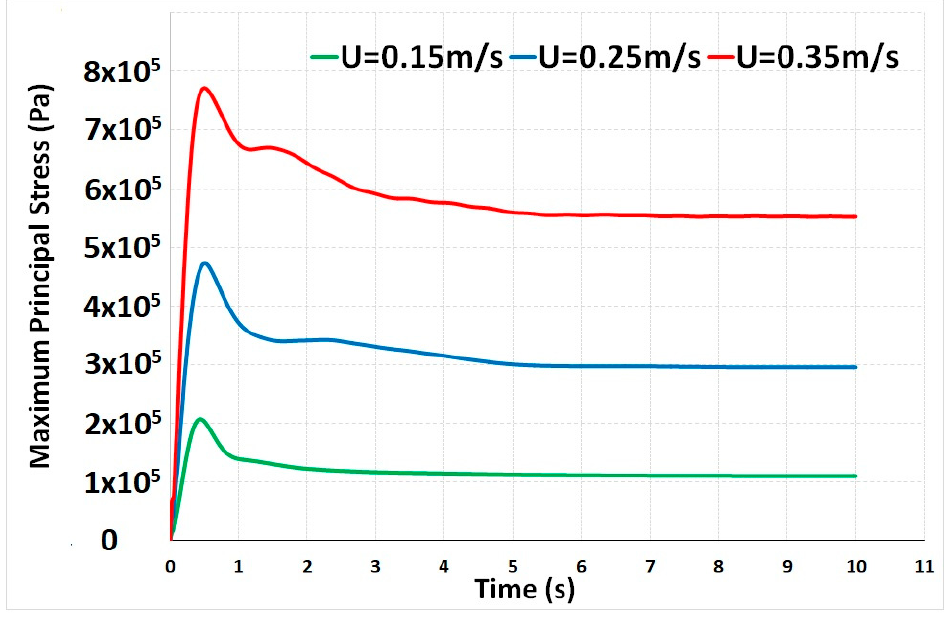
( a ) ( a ) Figure 11. Cont